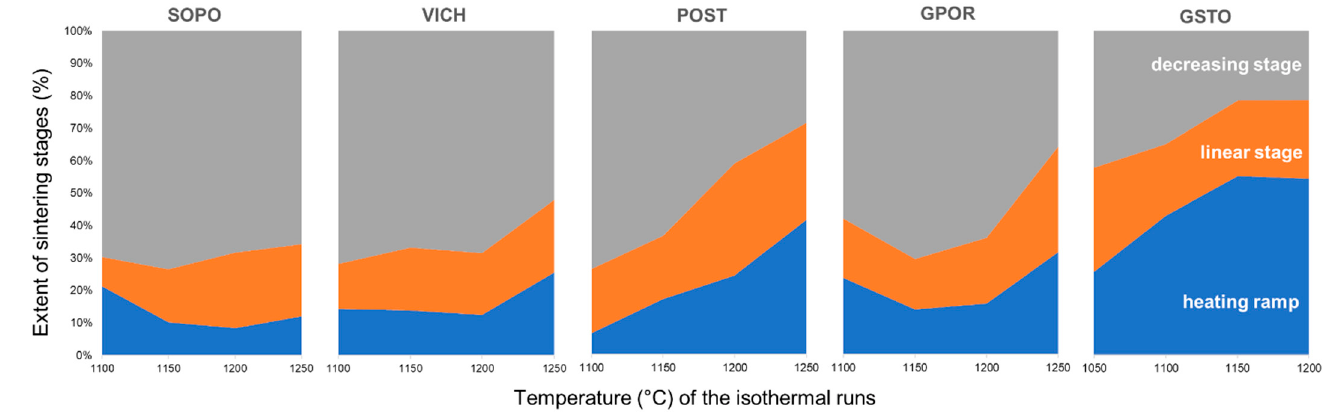
Figure 2. Extent of densification stages duration vs temperature (°C) of isothermal runs.